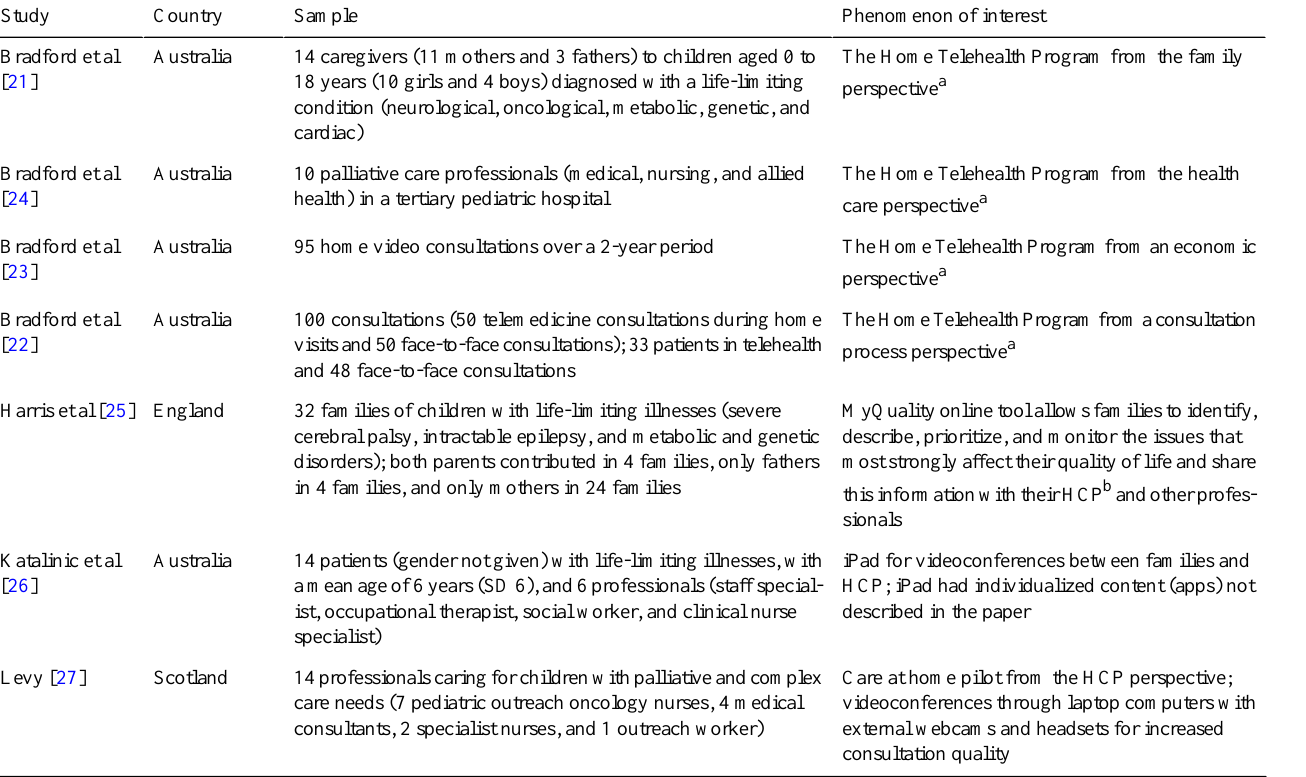
Table 2. Study sample and phenomenon of interest.